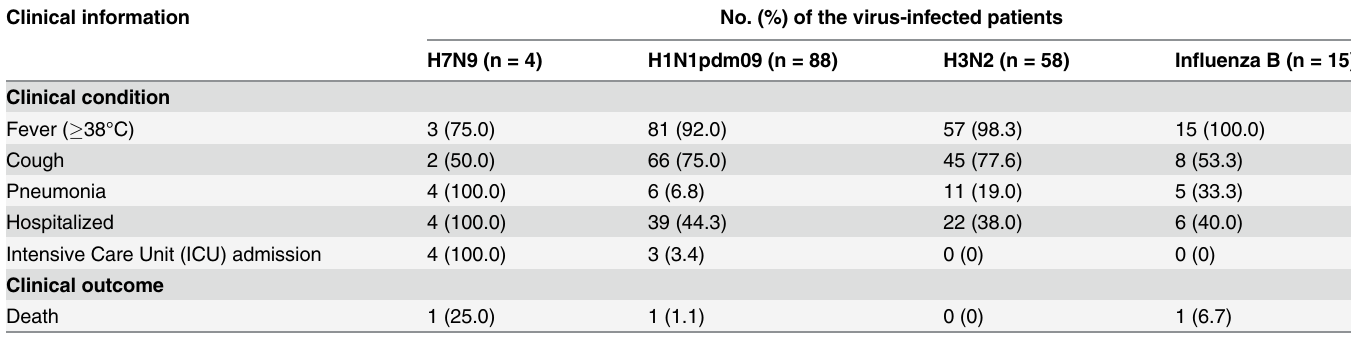
Table 1. Comparison of clinical information between the H7N9- and seasonal in fl uenza virus-infected patients con fi rmed in an enhanced in fl uenza surveillance of H7N9 in Taiwan, from April 3, 2013 to May 12, 2014. Clinical information No. (%) of the virus-infected